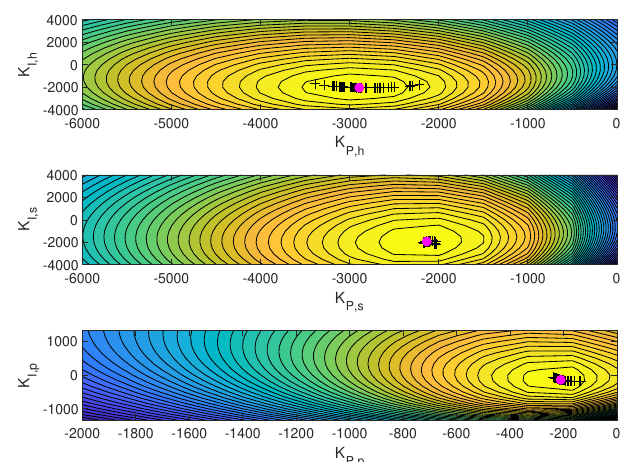
Fig. 13: Gain tunings for 20% uncertainty in the inertial term for sea-state 10A.